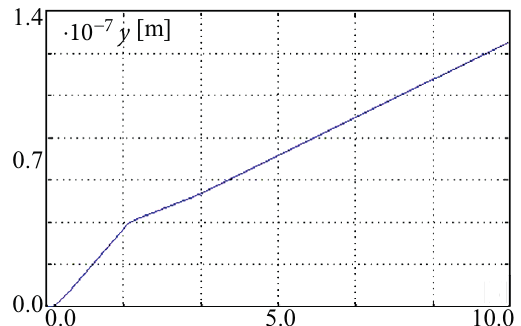
Fig. 12. Angle of rotation φ( t ) about the OX -axis